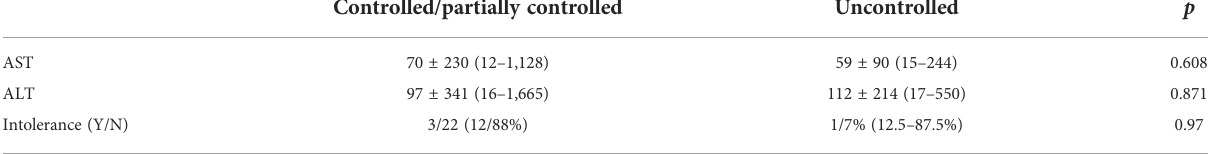
Dose HK K value Disease (mg) episodes